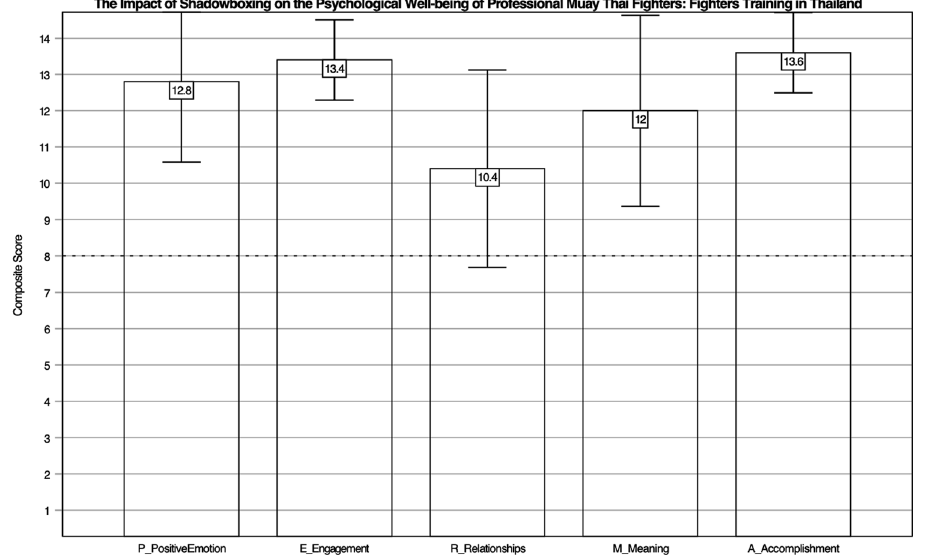
Fig. 6 This figure provides a bar plot with 95% confidence intervals (CIs) for composite PERMA scores: Nak Muays training in Thailand (n = 5). For each element of psychological well-being, the lowest possible composite score is 2 representing that professional Nak Muays strongly agree that shadowboxing negatively impacts that element of psychological well-being, whereas the highest possible composite score is 14 representing that professional Nak Muays strongly agree that shadowboxing positively impacts that element of psychological well-being. A composite score of 8 (dotted line) reflects a neutral position on whether shadowboxing contributes positively or negatively to that element. Results in this figure show that Nak Muays training in Thailand strongly agree that shadowboxing positively contributes to all elements of their psychological well-being. Further, results in this figure show that shadowboxing contributes to the elements of psychological well- being in the following rank-order for Nak Muays training in Thailand: accomplishment (A), engagement (E), positive emotions (P), meaning (M), and relationships